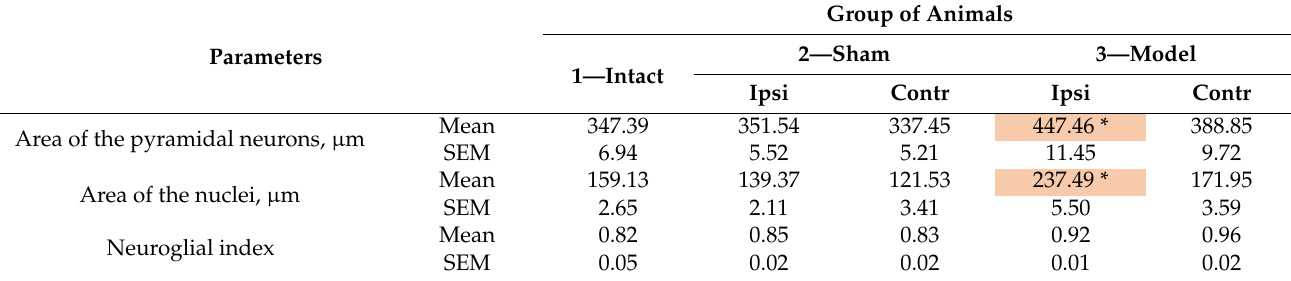
Table 7. The neurons’ morphometric parameters in the V layer of the sensorimotor neocortex.